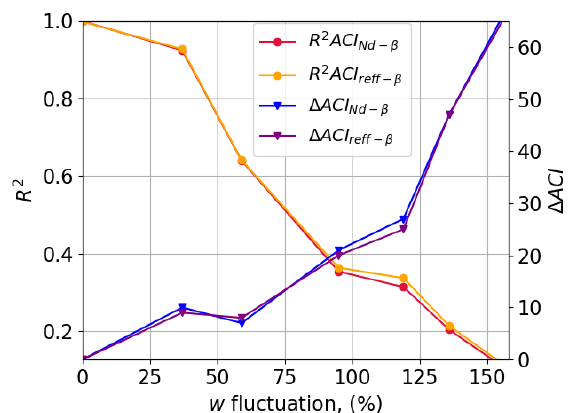
Figure 14. Correlation coefficients ( R 2 ACI ) and variability ( ∆ ACI) for ACI Nd − β and ACI ref f − β as a function of the fluctuation of the updraft velocity ( w ) using LARSS.